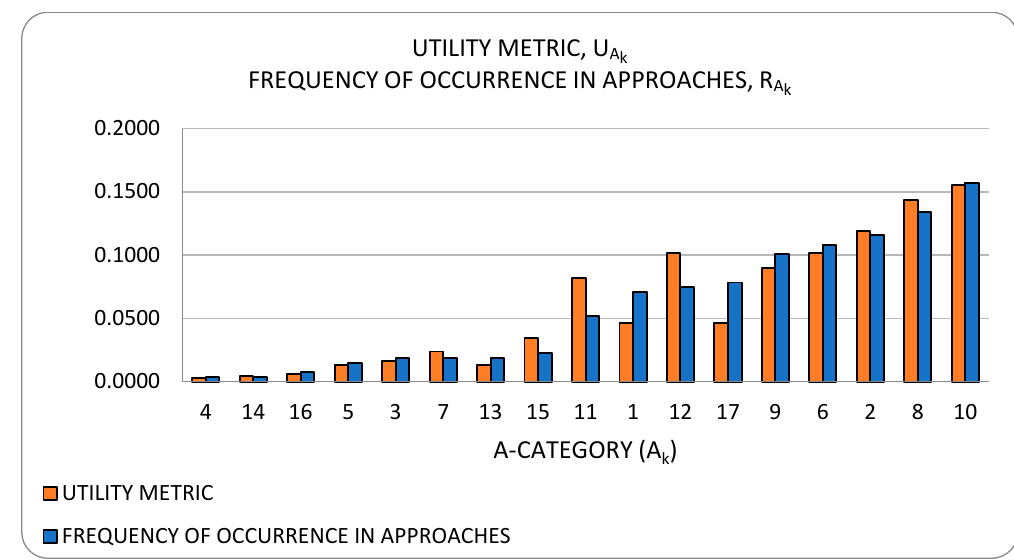
Figure 21. Approach metrics.